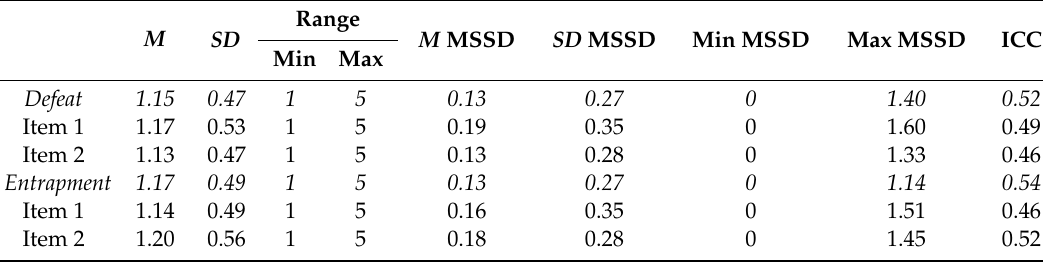
Table 1. Descriptive statistics and variability indices of the ecological momentary assessment (EMA) scales of defeat and entrapment.